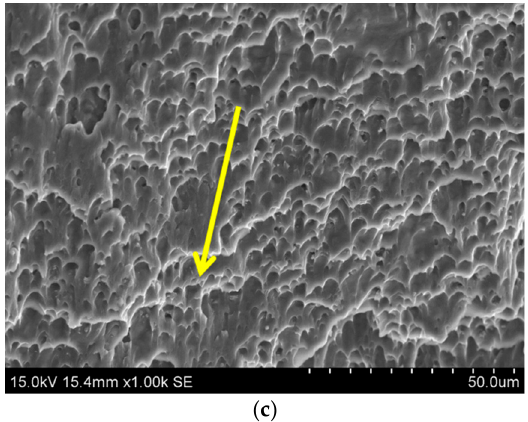
Figure 9. ( a ) T-type joint weld fatigue fracture; ( b ) weld crack propagation area; and, ( c ) weld transient area.